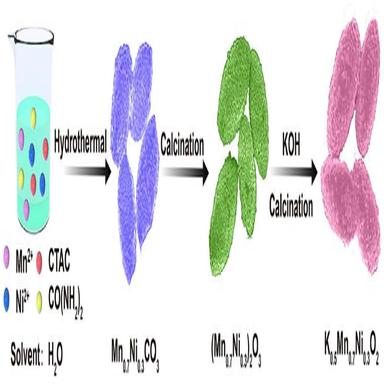
Schematic diagram of the synthesis steps of KMNO cocoons.